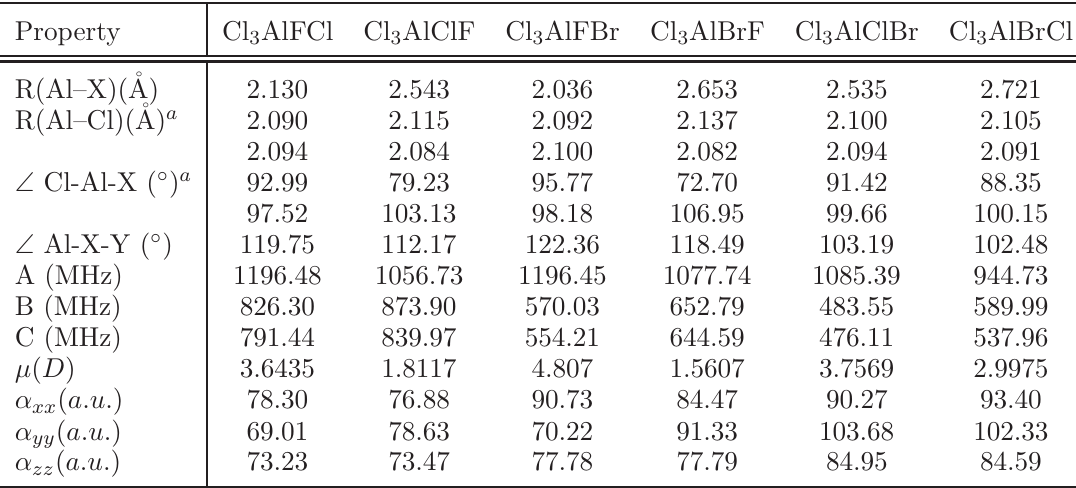
Table 6 Relevant optimized bond lengths and bond angles, rotational constants, dipole moments and static polarizability of the stable Cl complexes (X = Y = F, Cl, and Br).